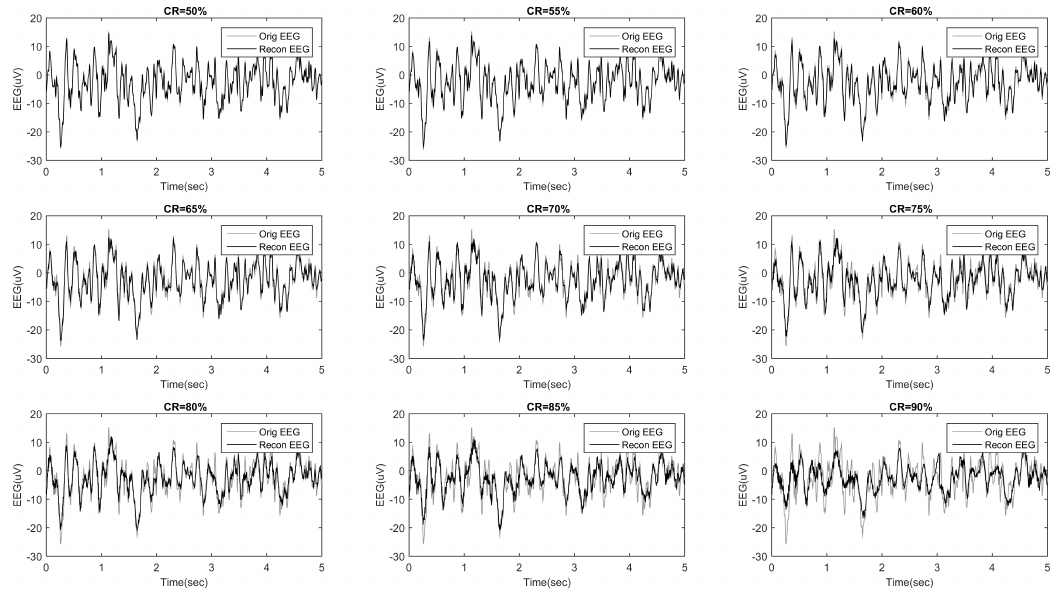
Figure 3. The original EEG recorded at channel E2 ( gray ) and the related compressively sensed signals ( black ) reconstructed at different compression rates